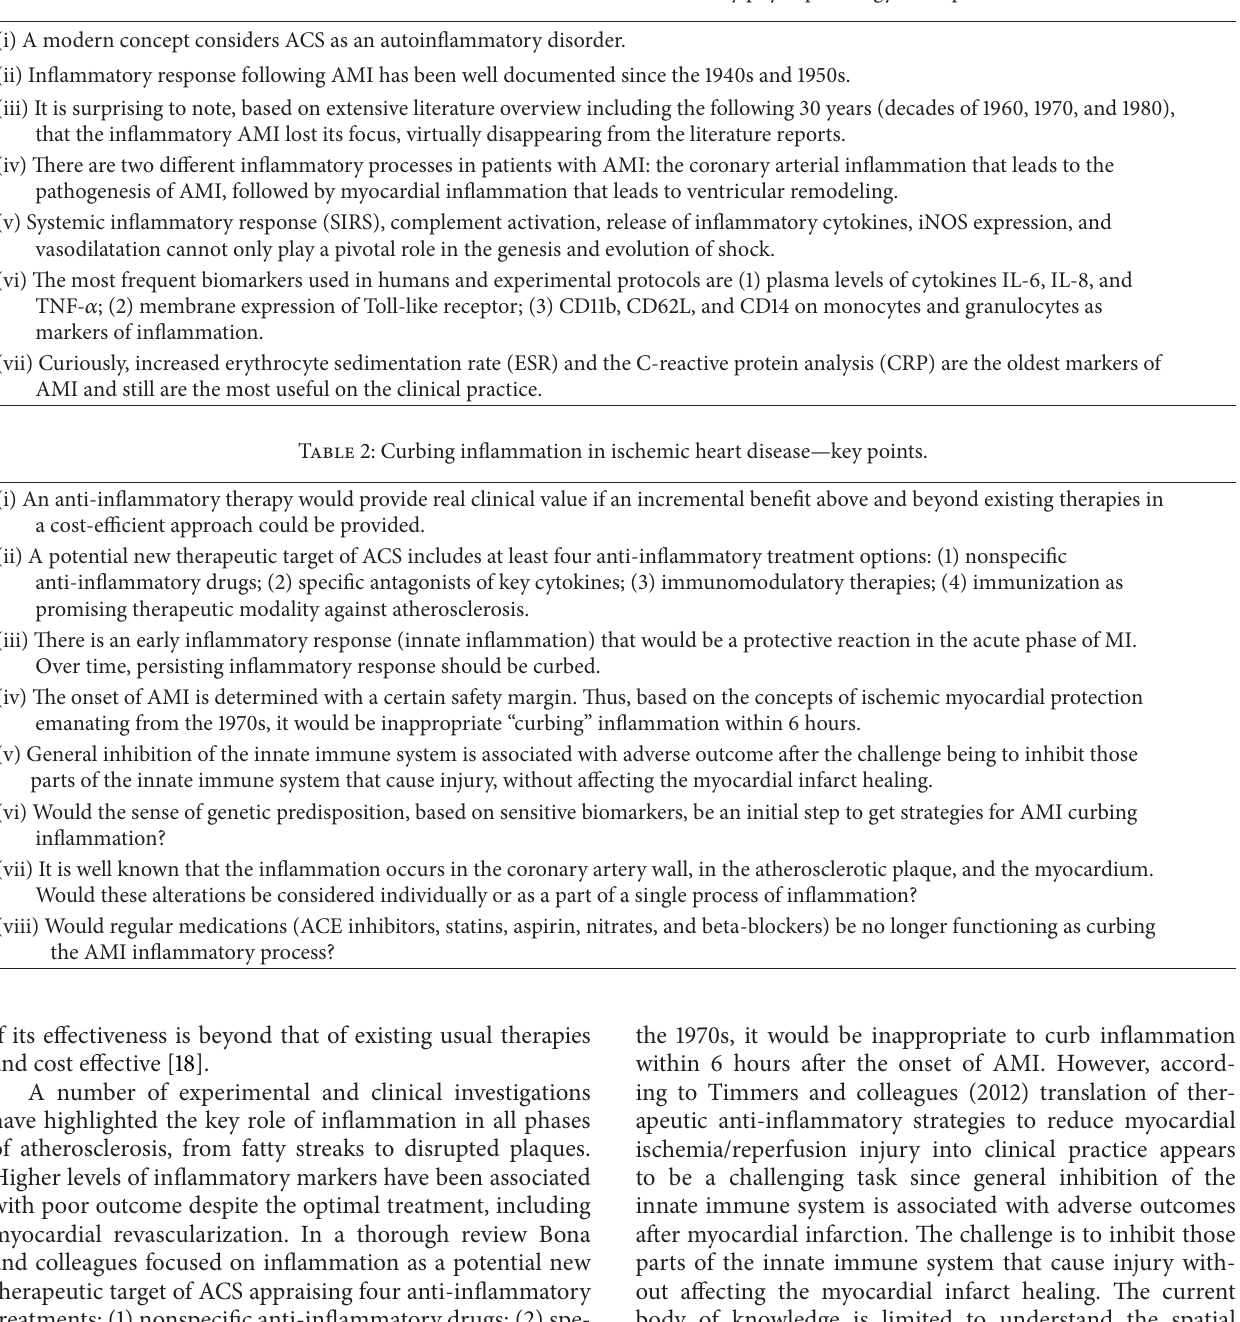
Table 1: Ischemic heart disease and inflammation—key physiopathology concepts.